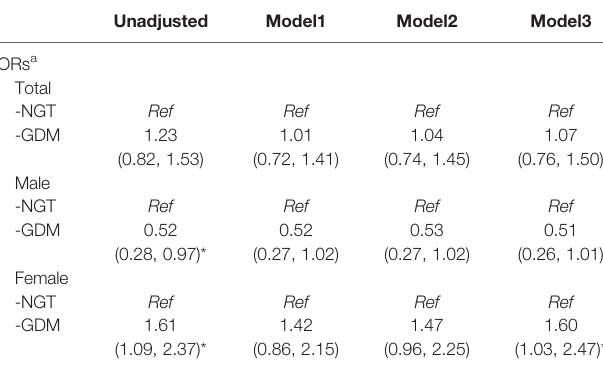
TABLE 3 | Multivariable models for the association of GDM and offspring overweight or obesity (BMI ≥ 85th percentile) at 1 year of age. Unadjusted Model1